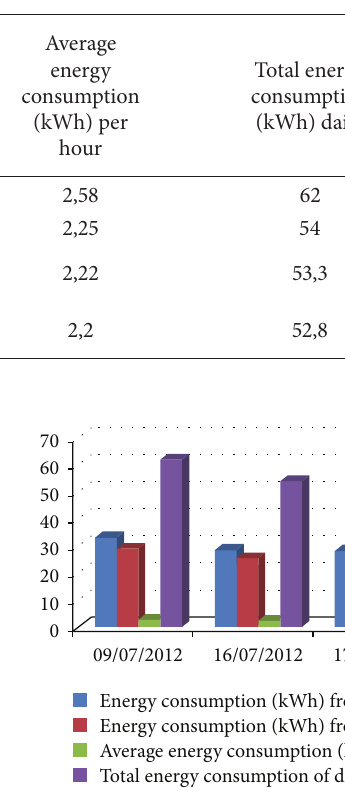
Table 10: Comparison between the energy consumption of the site, case of a day not applying the proposals of energy savings (09/07/2012) and case of days applying the proposals of energy savings (16, 17, and18 July 2012): Maroua Market site.